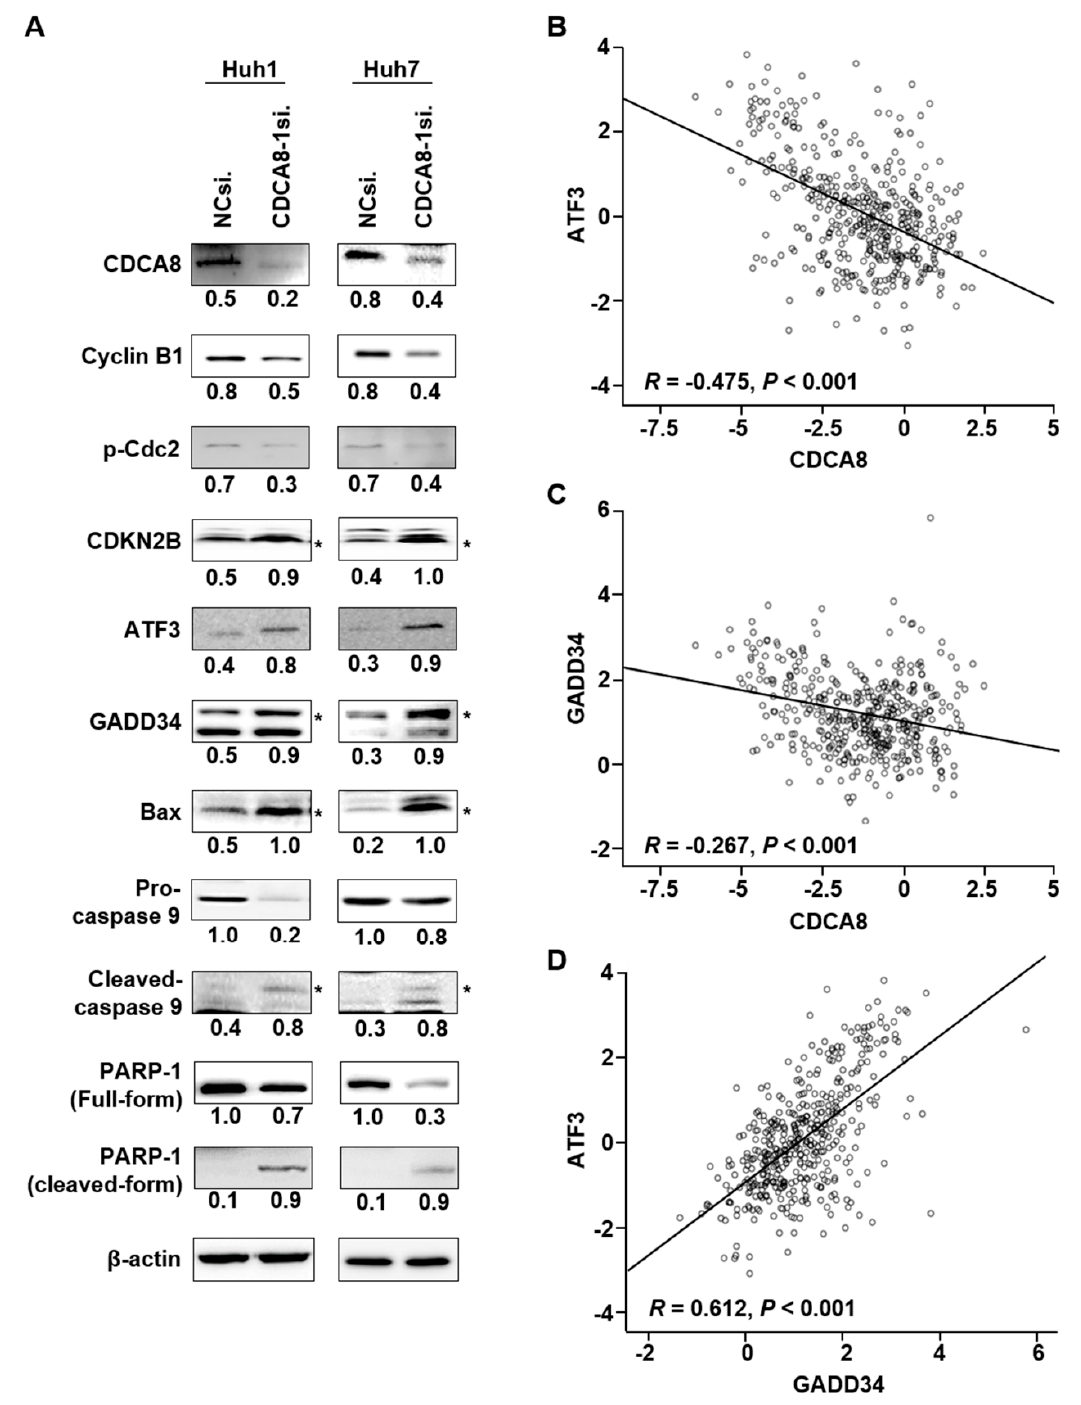
Figure 6. Targeting CDCA8 enhances apoptotic signaling through activation of the ATF3 and GADD34 tumor suppressors. ( A ) Western blot analysis of the expression of CDCA8 and the indicated proteins functionally related to cell proliferation, apoptosis, or cell cycle regulation. The proteins were prepared at 48 h after transfection with CDCA8-1siRNA. β -actin was detected as a loading control. *exact position of target protein band when measured with molecular weight markers (refer to Figure S5 and Figure S6). ( B – D ) The correlation among the expressions of CDCA8, ATF3, and GADD34 in HCC tissues. TCGA data showed that CDCA8 had a negative correlation with ATF3 ( B ) and GADD34 ( C ), and there was a positive association between ATF3 and GADD34 ( D ).